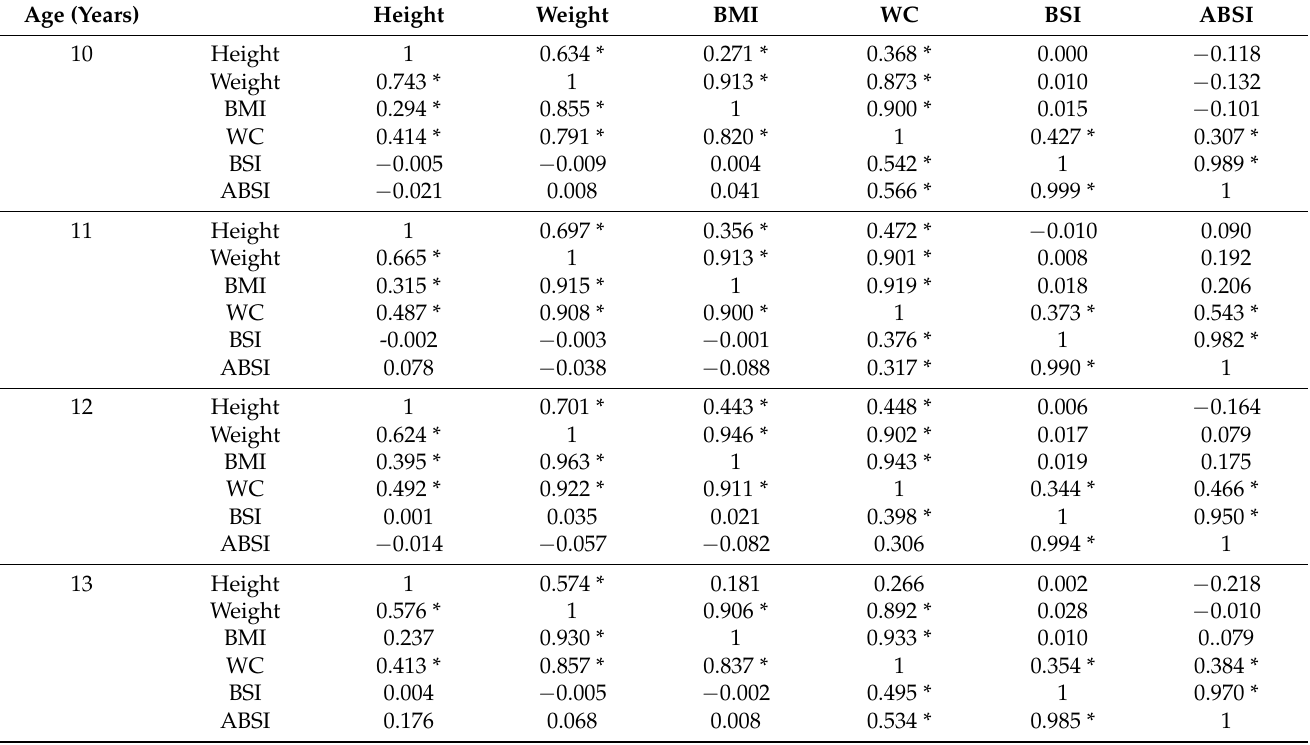
Table 5. Correlations among height, weight, BMI, WC, and BSI in boys and girls according to